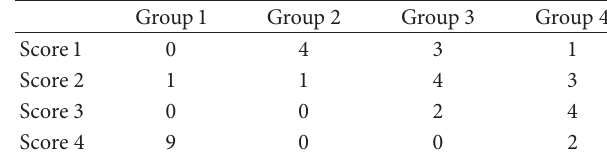
Table 1: Frequency of microleakage